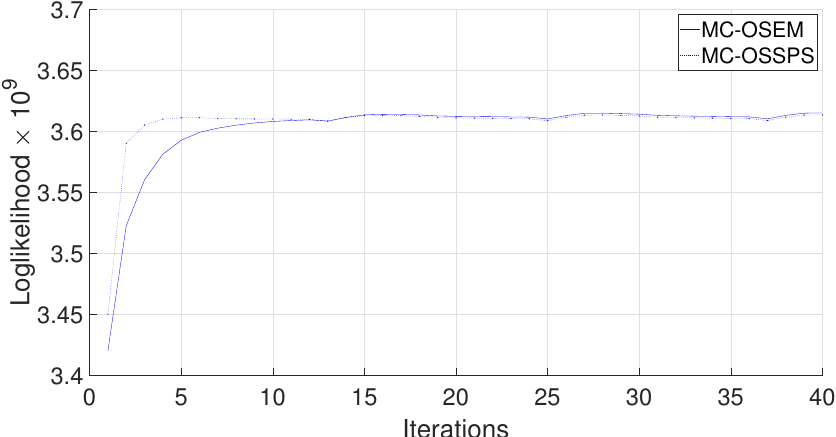
Figure 3. Loglikelihood vs. iteration number for MC-OSEM and MC-OSSPS. In both cases 12 subsets were employed.